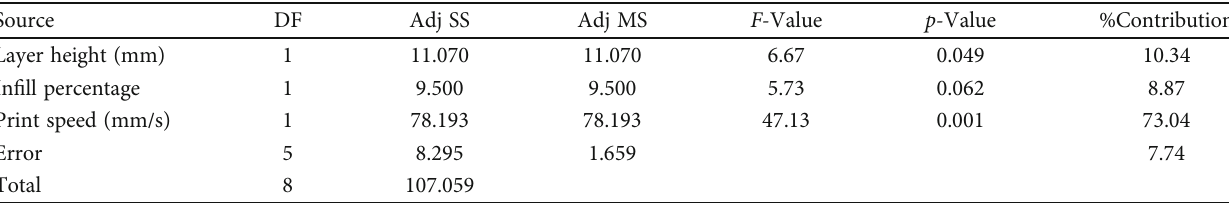
Table 3: Analysis of variance for tensile strength.